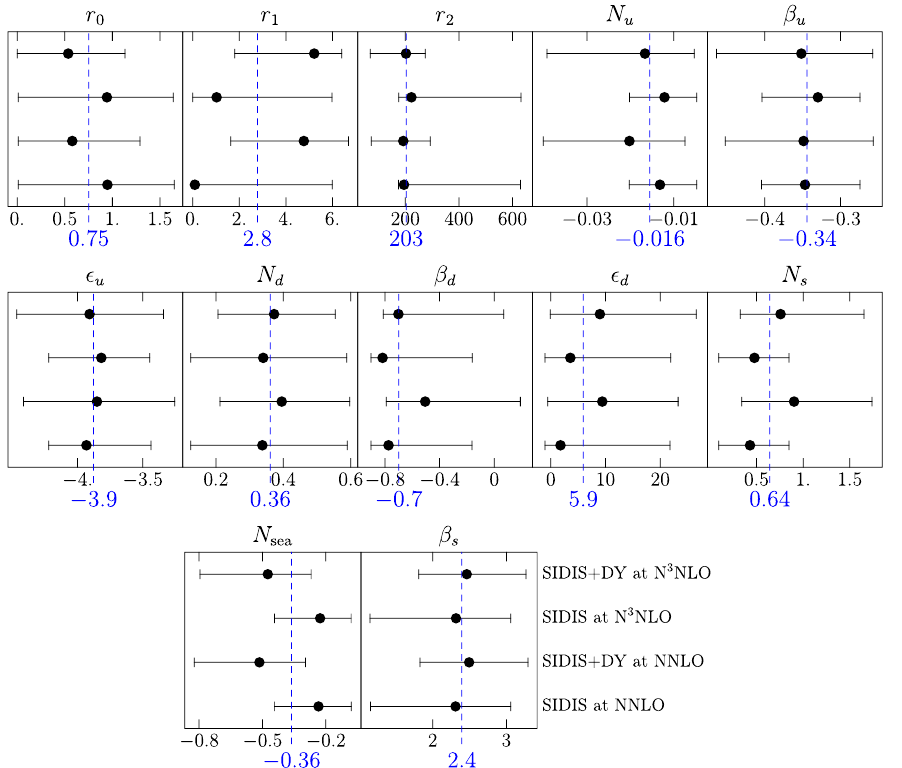
Figure 6. The comparison of values for model parameters obtained in fits. Numerical values of parameters are given in table 4. The blue dashed line and blue numbers show the average over all fits, in order to estimate the stability of fit